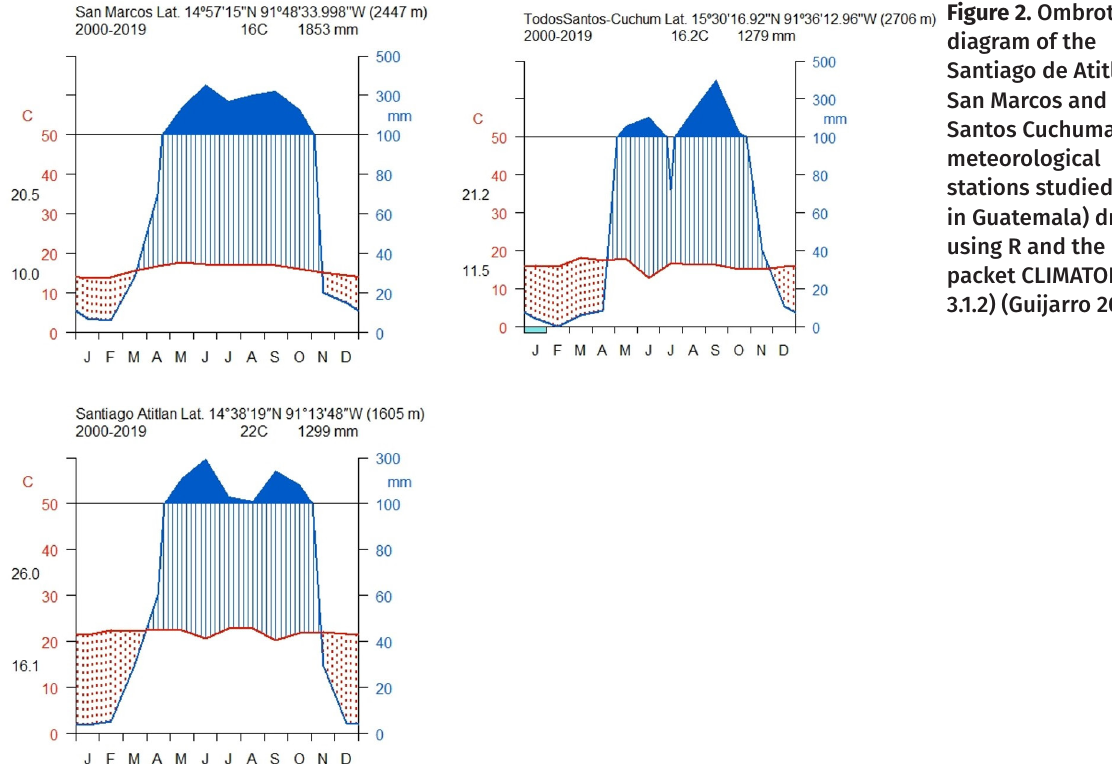
Figure 2. Ombrotermic diagram of the Santiago de Atitlán, San Marcos and Todos Santos Cuchumatanes meteorological stations studied (all in Guatemala) drawn using R and the packet CLIMATOL (v. 3.1.2) (Guijarro